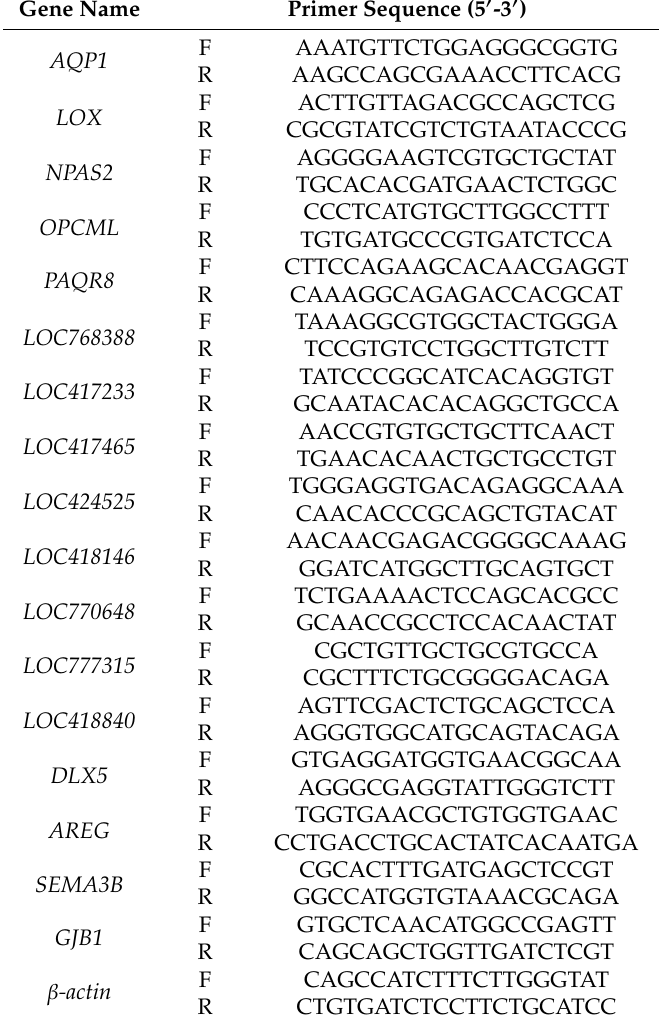
Table 2. The primers for